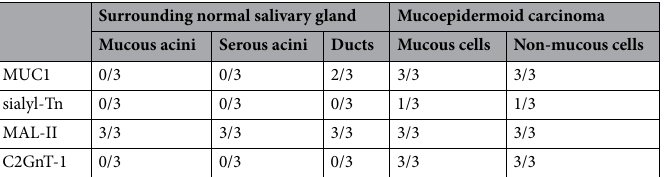
Table 2. MUC1, Sialyl-Tn, MAL-II and C2GnT-1 expressions in normal salivary glands and mucoepidermoid carcinomas.